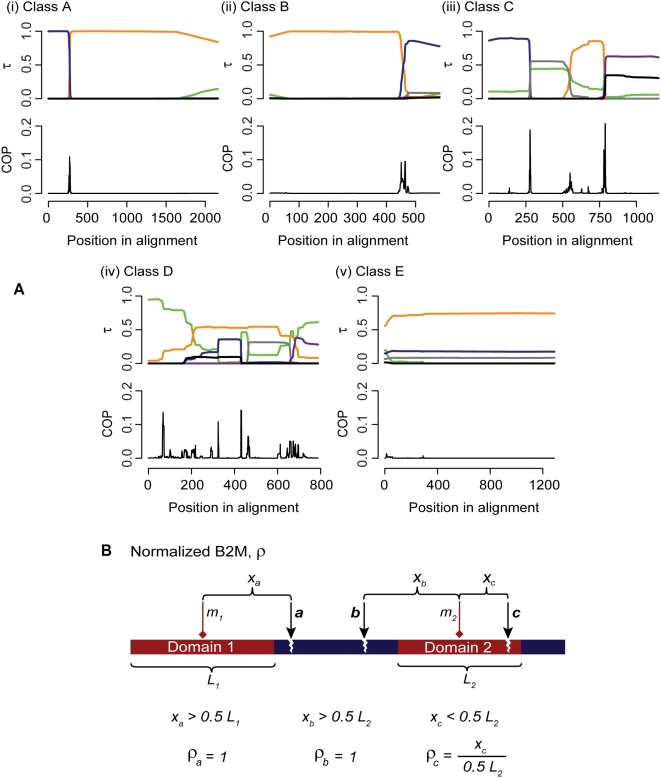
Inference of recombination breakpoints with respect to annotated protein domains.(A) Classification of results in breakpoint identification based on outputs of DualBrothers [25]. In each panel the X-axis represents the positions in the sequence alignment, the Y-axis of the upper graph shows the Bayesian posterior probability (τ) of the inferred tree topology, and each colored line indicates a distinct topology (five major topologies are shown; the green line represents the sum of remaining tree topologies). The Y-axis of the lower graph in each panel shows the marginal posterior probability that an alignment position (column) is a breakpoint. Examples are shown for each of classes A–E. Classes A–C present clear evidence of recombination, Class D contains inconclusive cases, and Class E consists of cases for which we find no evidence of recombination. (B) Definition of ρ. A protein sequence is illustrated with two predicted domains. The midpoint of each domain is represented by a red diamond (m1 and m2). Three breakpoints (a–c) are illustrated as black arrows. The ρ denotes the number of amino acids between an observed breakpoint and the midpoint of the nearest domain, divided by the half-length of the corresponding domain (0.5 L), with ρmax = 1 (where the breakpoint is located at or outside the domon boundary in an aligned gene-sequence set).